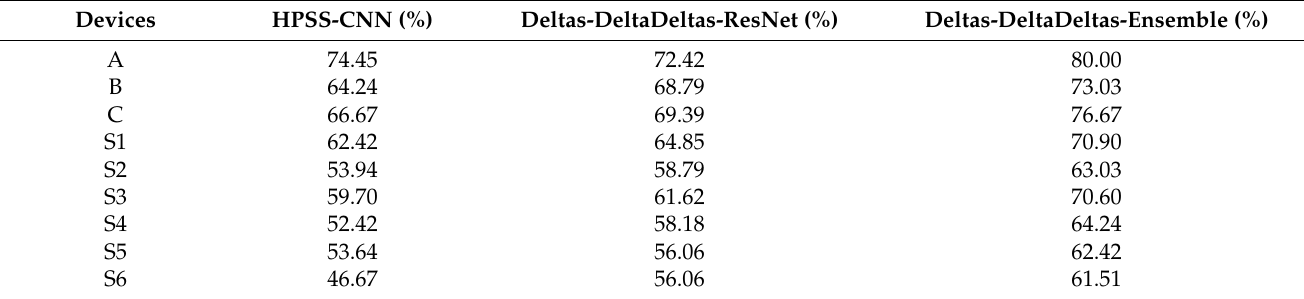
Table 3. Subtask A device-wise performance. Devices A, B, C, and S1–S3 are seen devices, and S4–S6 are unseen devices. HPSS-CNN (%), Deltas-DeltaDeltas-ResNet (%), and Deltas-DeltaDeltas-Ensemble (%) are class-wise accuracy of the development